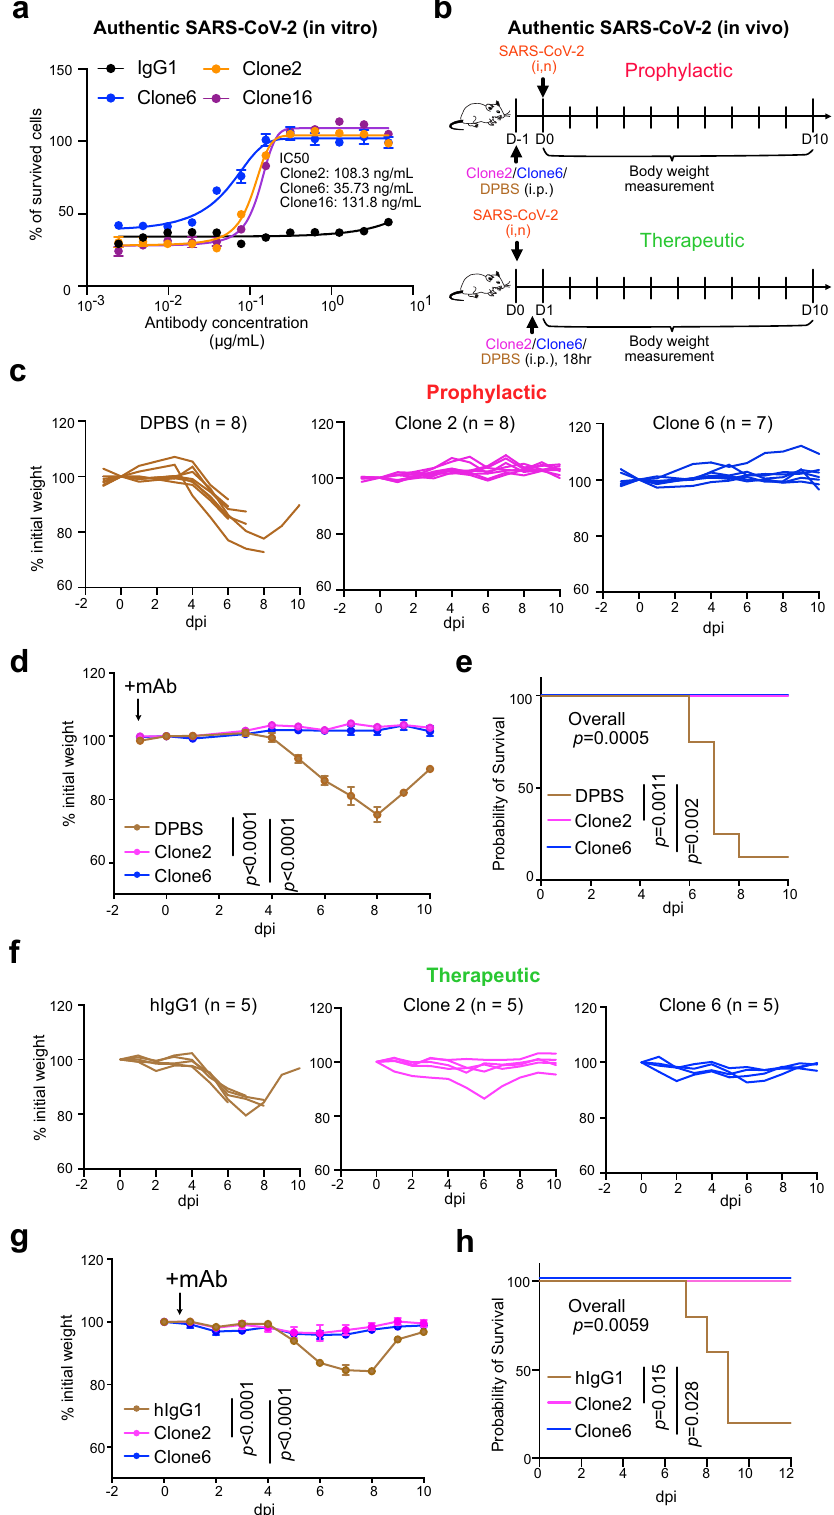
The mutation-induced side-chain orientation, as well as nearby loop conformation change plus distinct antibody